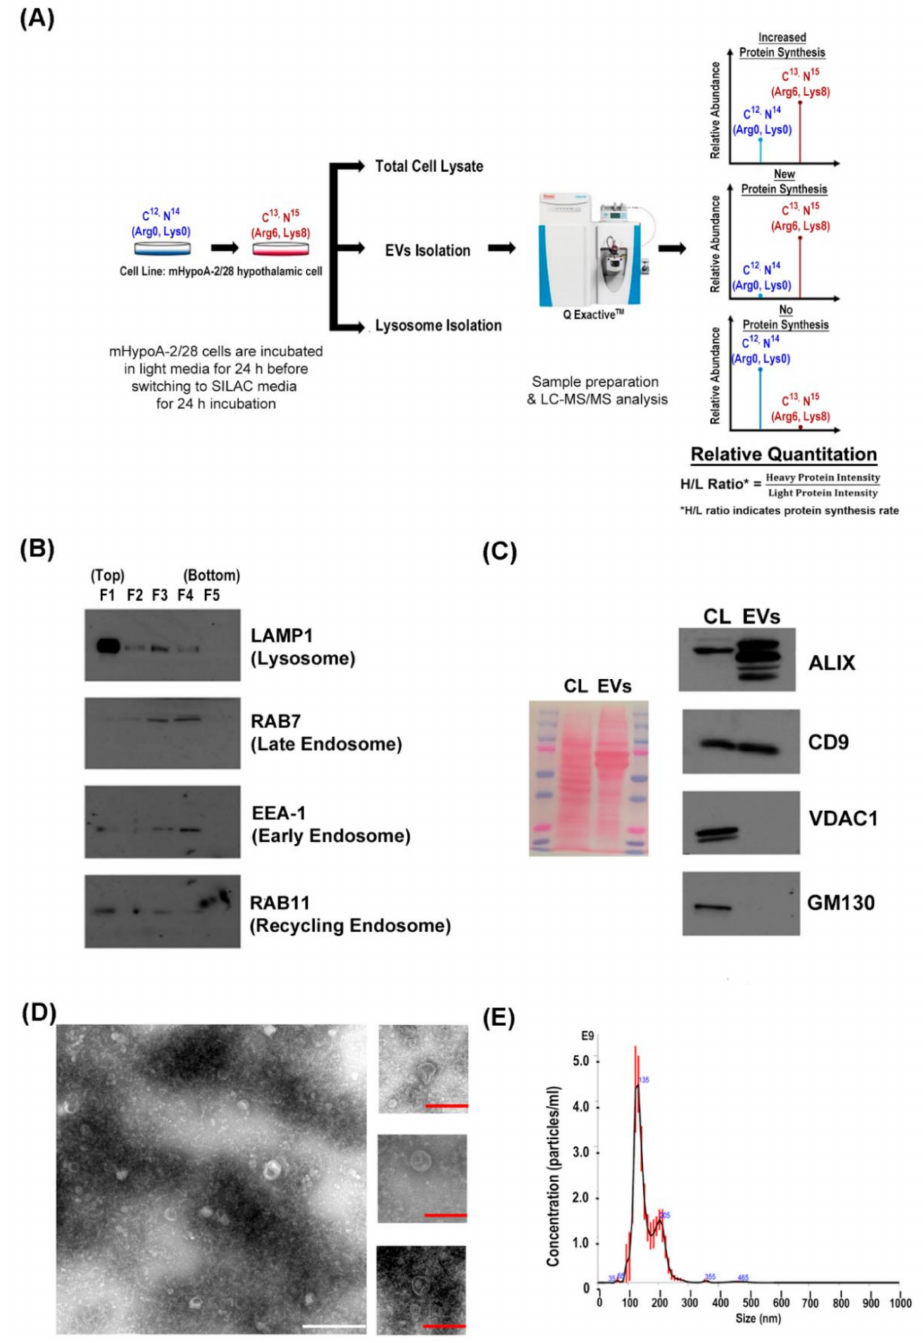
Figure 1. Characterization of lysosomes and EVs isolated from mHypoA 2 / 28 cells for pSILAC-based quantitative proteomics. ( A ) Schematic diagram illustrating the workflow of pSILAC-based quantitative proteomics analysis of EVs biogenesis through H / L ratio analysis. ( B ) Lysosome isolation was performed using density gradient centrifugation and five fractions were obtained. Equal volume from each fraction were loaded for immunoblotting analysis of lysosomal (LAMP1) and endosomal [EEA-1 (early), RAB7 (late), RAB11 (recycling)] protein markers. ( C ) 50 µ g of cell lysate (CL) and EVs proteins were used to probe for known exosomal markers (ALIX and CD9), mitochondrial marker (VDAC) and golgi marker (GM130). Ponceau S staining showed equal loading of proteins for analysis. ( D ) Wide field and closed up TEM images obtained from negative staining of mHypoA 2 / 28 EVs. The white scale bar represents 500 nm and the red scale bar represents 200nm. ( E ) Nanoparticle tracking analysis of mHypoA 2 / 28 derived EVs a mean diameter of 158.8 ± 1.3